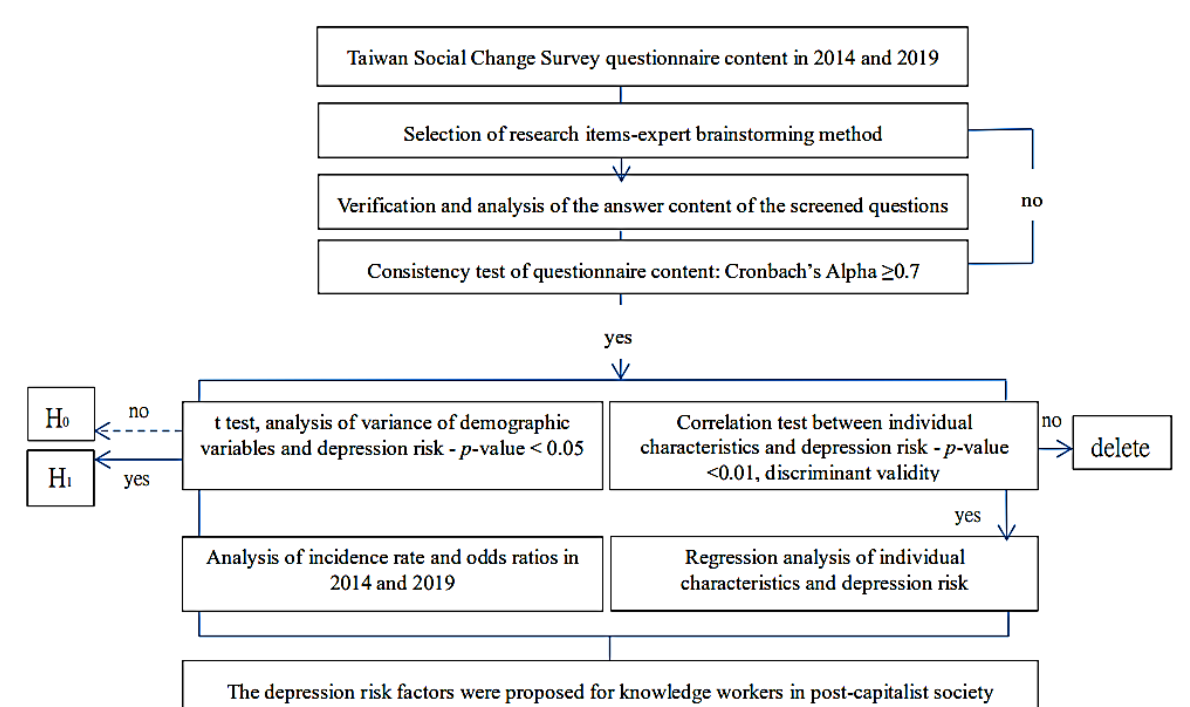
Figure 1. Study design.